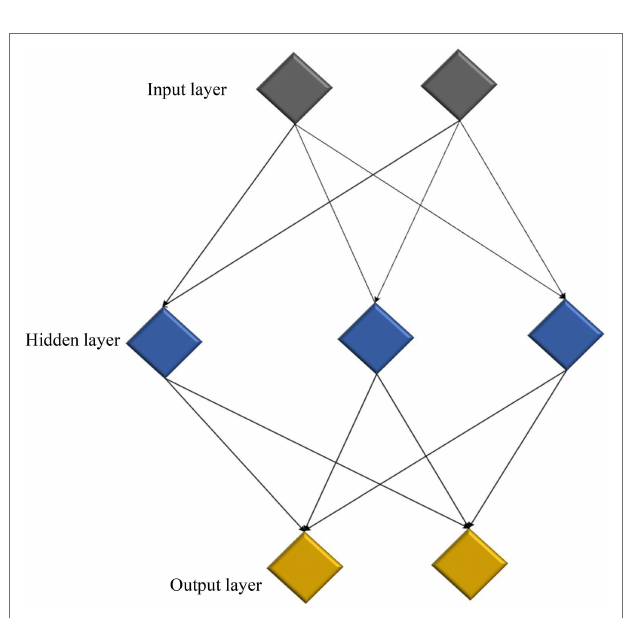
FIGURE 3 | Structure of the neural